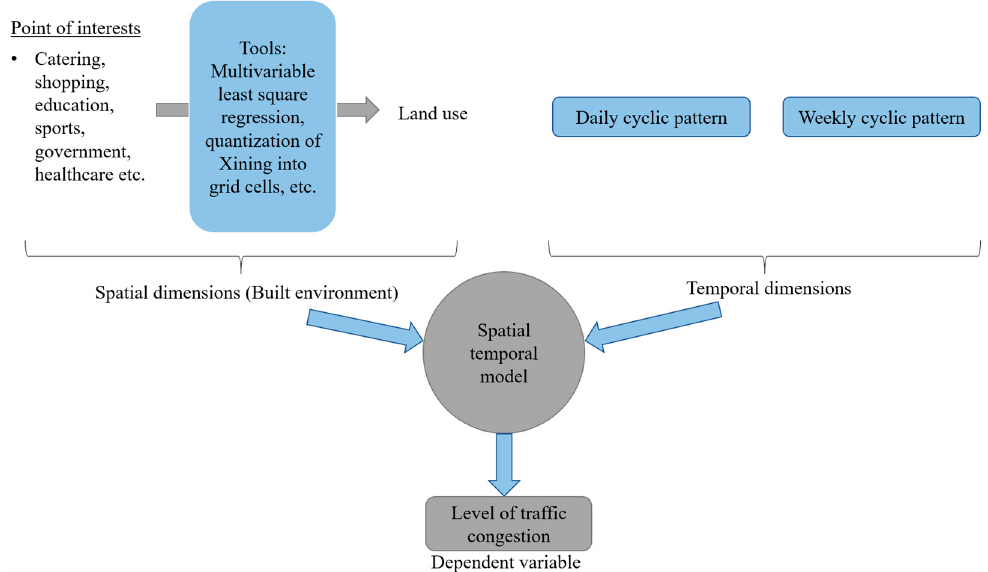
Figure 1. Conceptual framework to understand traffic congestion patterns in smaller urban areas.